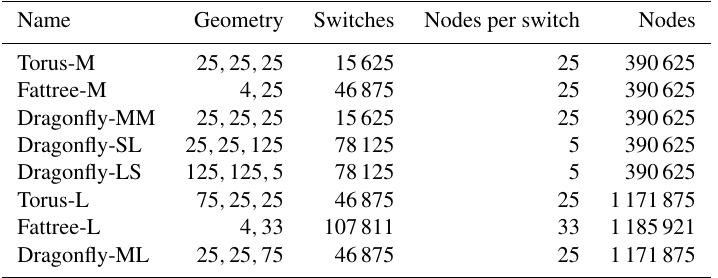
Table 1. Summary of the network topologies: the geometry of a torus topology specifies the size of each dimension; the first and second number in the geometry of a fattree topology are the number of layers and descendant ports per switch, respectively; the first two numbers and the last number in the geometry of a dragonfly topology indicate the group mesh size and the number of groups, respectively. Name Geometry Switches Nodes per switch Nodes Torus-M 25 , 25 , 25 15625 25 390625 Fattree-M 4 , 25 46875 25 390625 Dragonfly-MM 25 , 25 , 25 15625 Dragonfly-SL